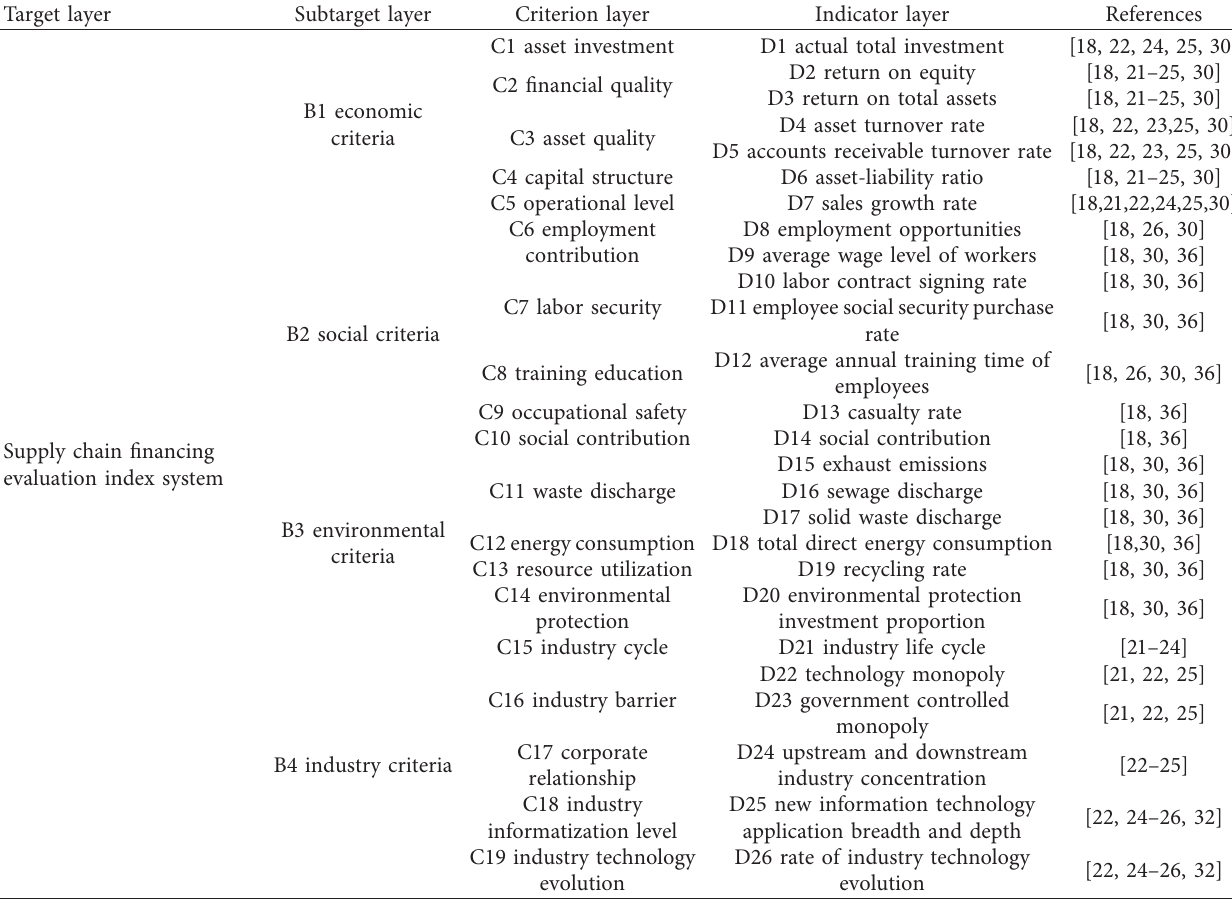
Table 1: Summary table of supply chain financing evaluation index